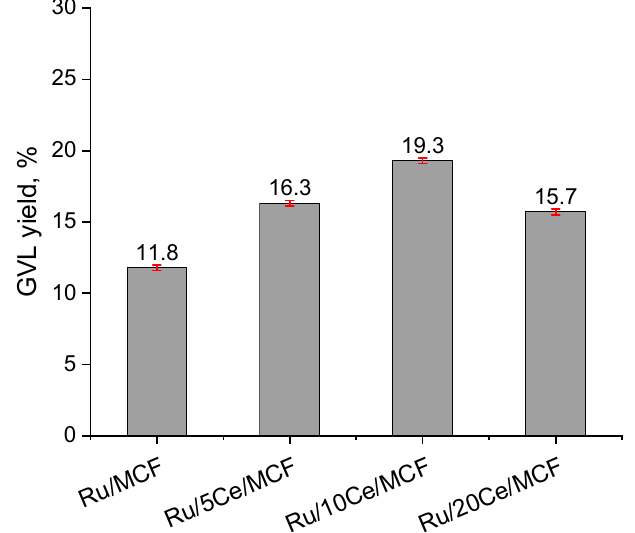
Figure 3. Catalytic activity of the catalysts in levulinic acid hydrogenation. GVL was the only identified product.